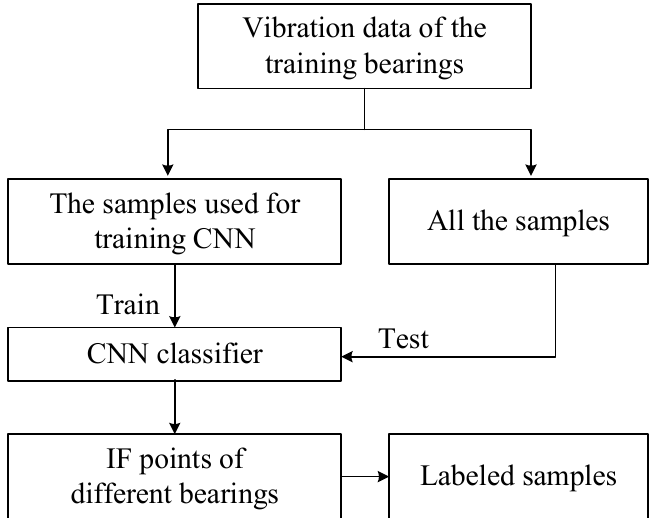
Figure 2. The flowchart of the CNN for IF point